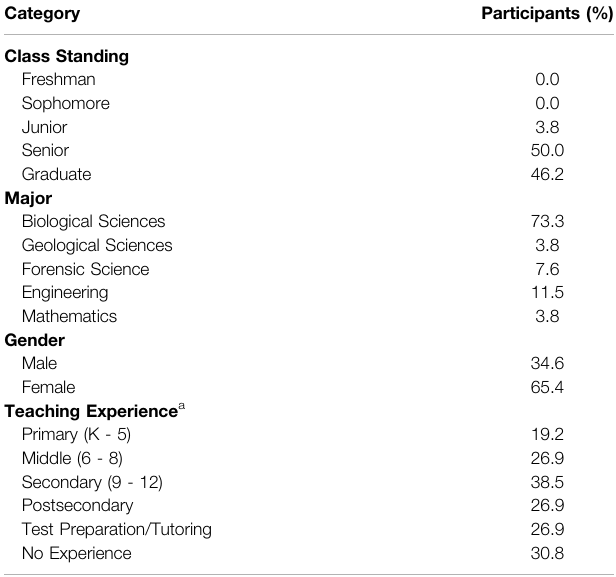
TABLE 2 | Demographic characteristics of action research module